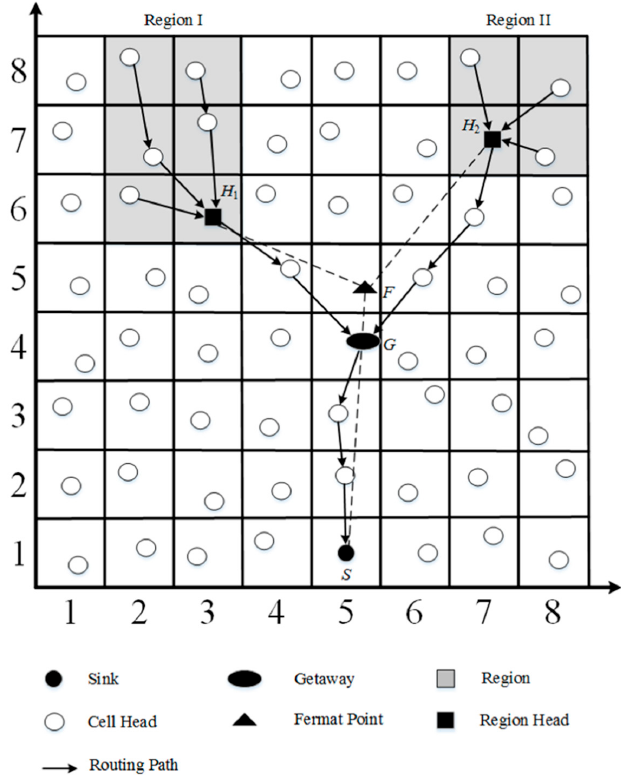
Figure 6. Energy efficient grid-based geocasting path construction.